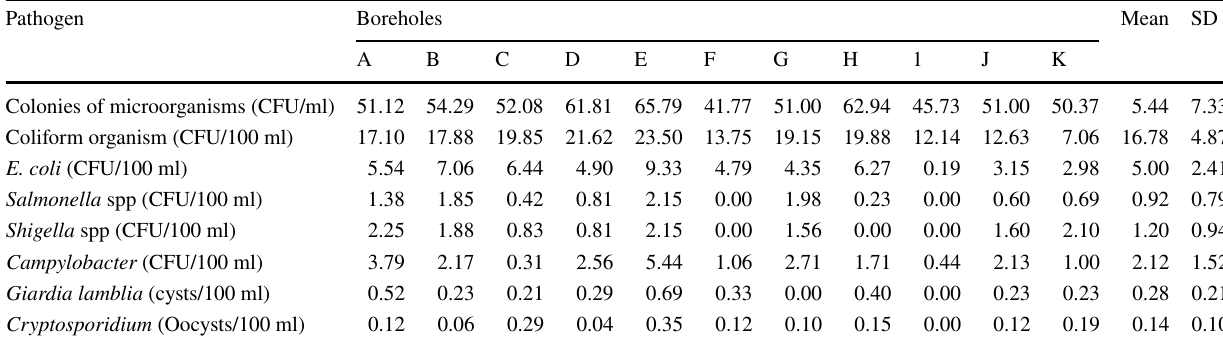
Salmonella spp (CFU/100 ml)